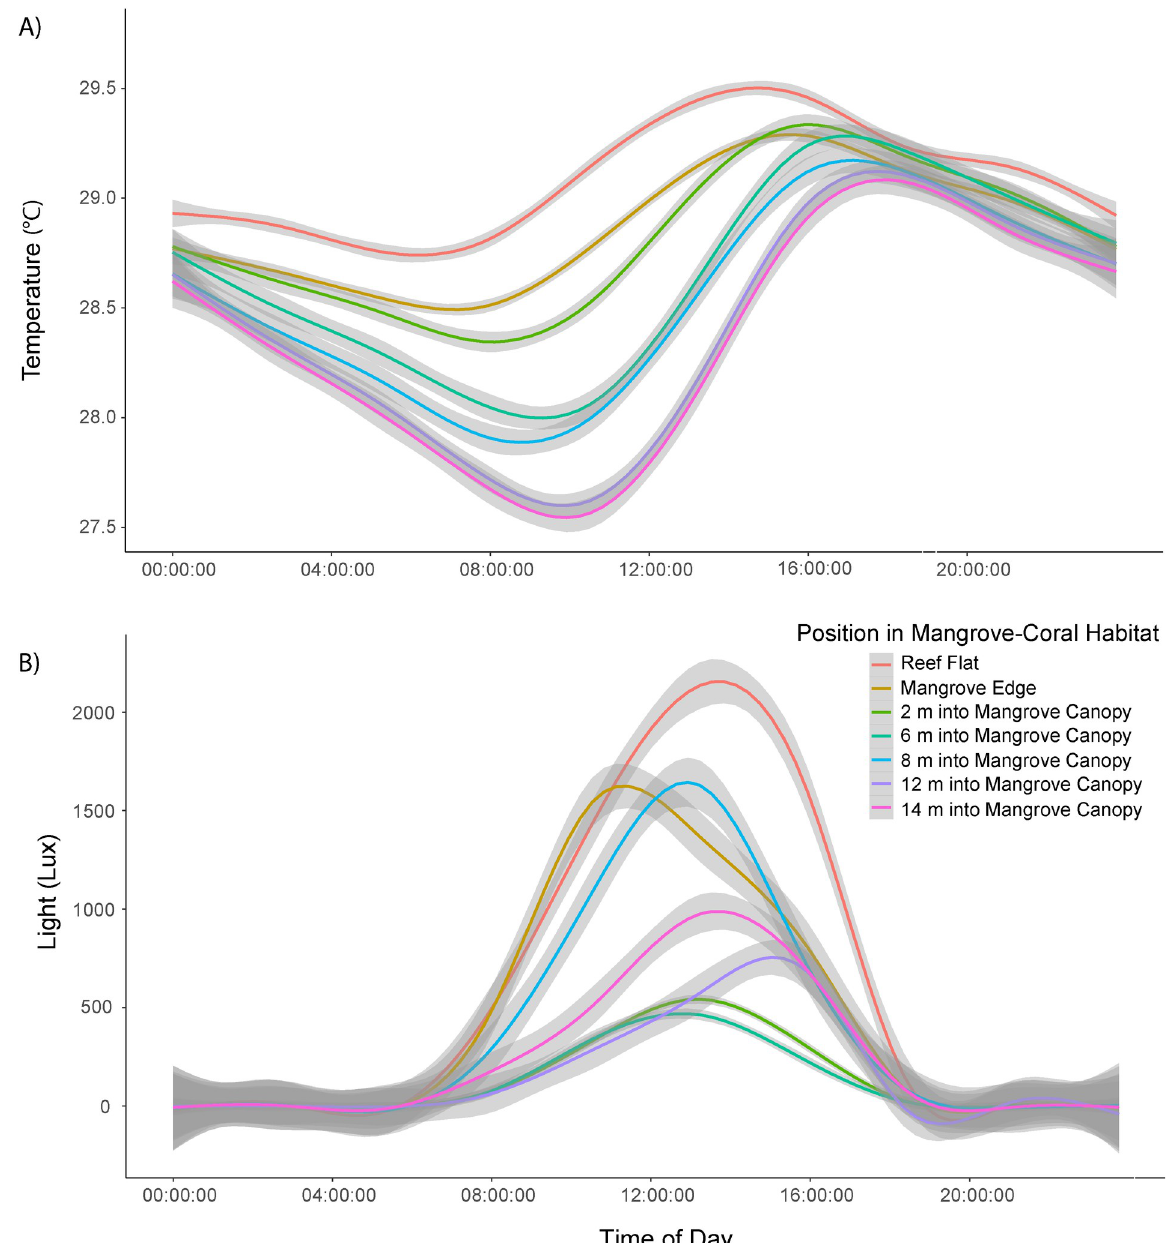
Fig 4. Daily (A) mean temperature and (B) mean light profiles. Data collected from June-July 2018 with 95% confidence interval (gray) of positions within mangrove-coral habitat on the reef flat (red), mangrove edge (gold), and mangrove canopy increasing every 2 m into the canopy from 2 m (green), 6 m (teal), 8 m (blue), 12 m (purple) to 14 m (magenta). Average water temperature was greatest on the reef flat and progressively decreased with depth into the mangrove